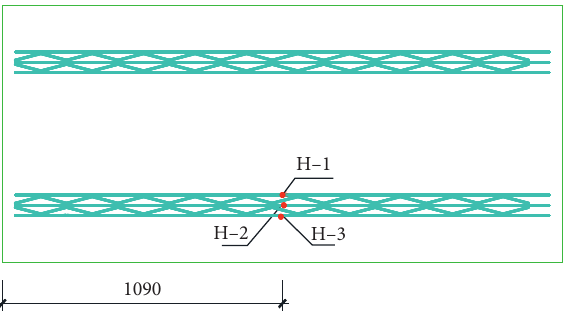
Figure 8: Arrangement of the strain gauges on the truss bar.